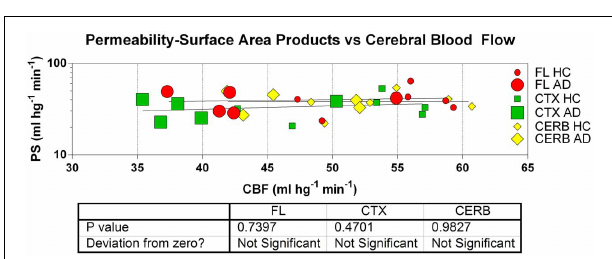
Ordinate (left panel) : Unidirectional [ 11 C ] PiB Clearance (ml hg − 1 min − 1 ). Ordinate (right panel) : Extraction fraction (ratio). Similar regional PS-products in the two groups explain numerically attenuated and insignificant differences of unidirectional clearances and extraction fractions.